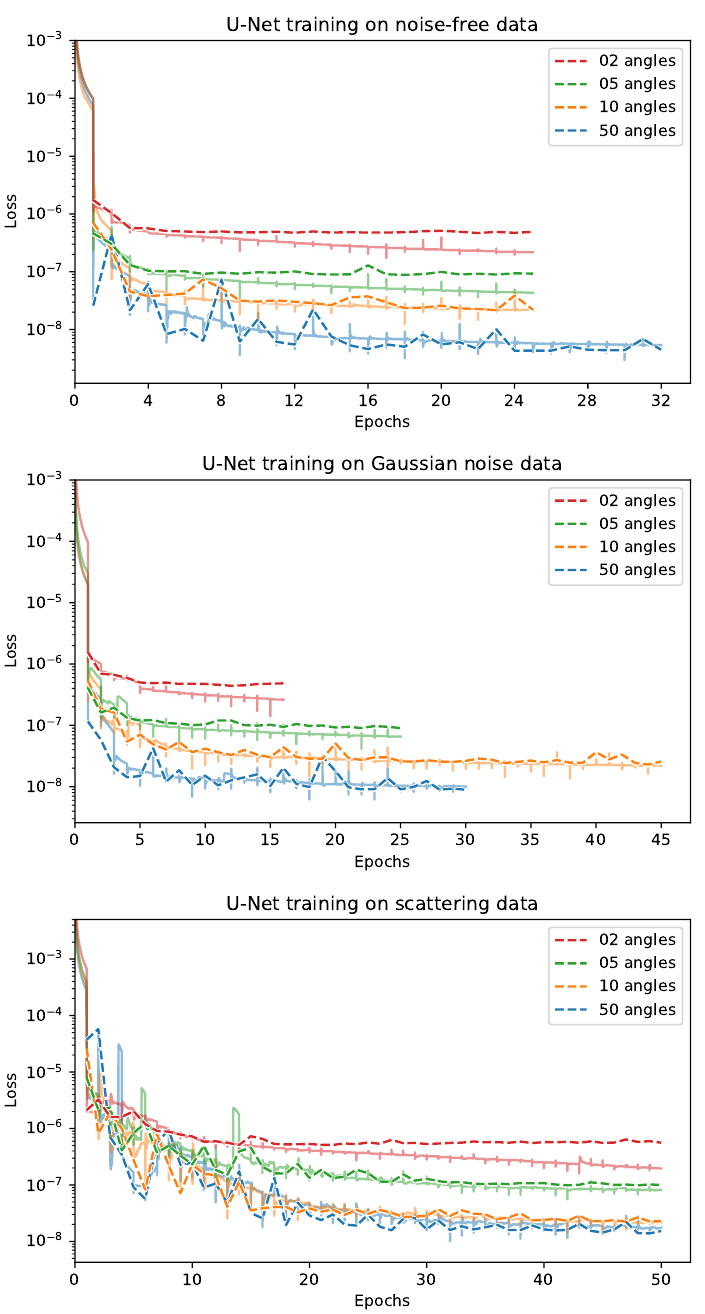
Figure A12. Training curves of U-Net on the Apple CT dataset. Dashed lines: average validation loss computed after every full training epoch; solid lines: running average of training loss since start of epoch. Duration of 20 epochs on full dataset: ≈ 1.5